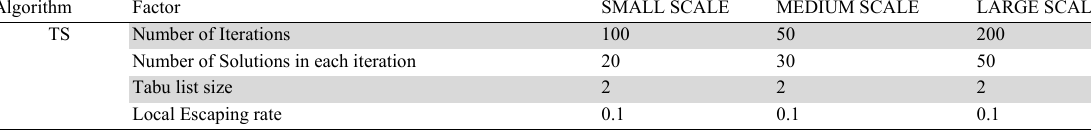
Estimated values for input parameters of TS-SA algorithm